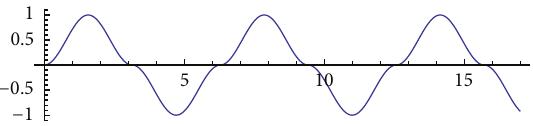
Figure 1: Function 𝑥(𝑡) = | sin (𝑡)| sin (𝑡) is a solution of (4).